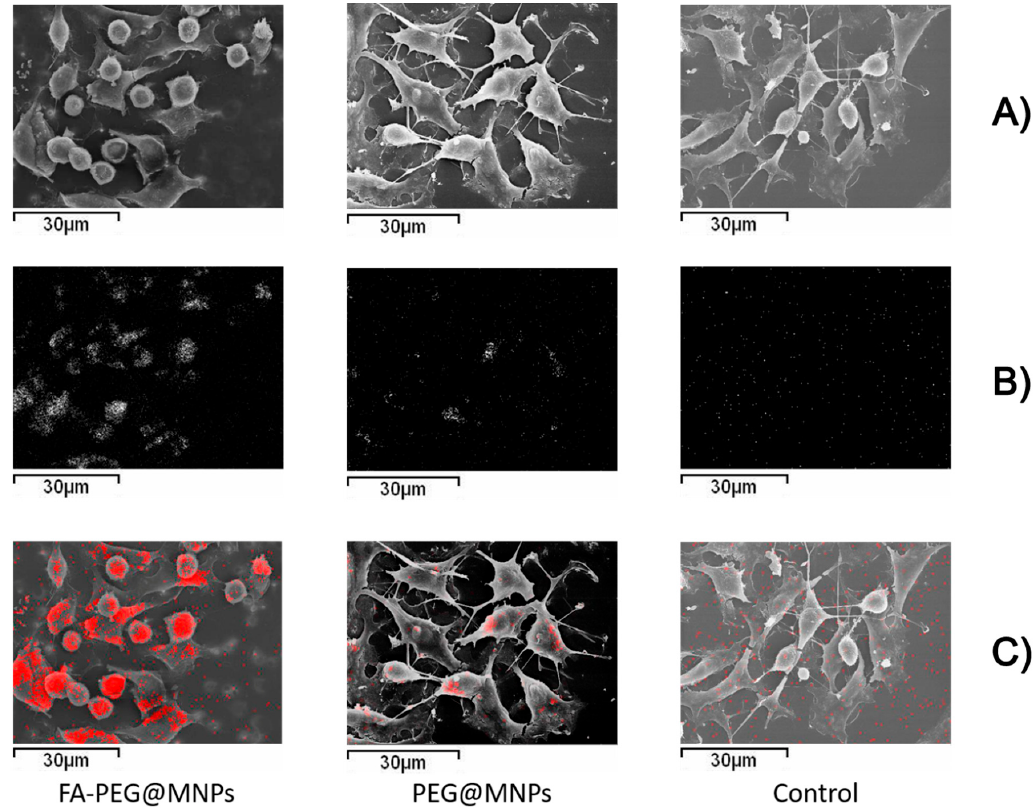
Figure 2. ( A ) SEM images, ( B ) EDX maps of Fe distribution (bright spots), and ( C ) overlay images of SEM and EDX Fe distribution (Fe spots colored red) of samples of untreated cells (control) and cells incubated with either FA-PEG@MNPs or